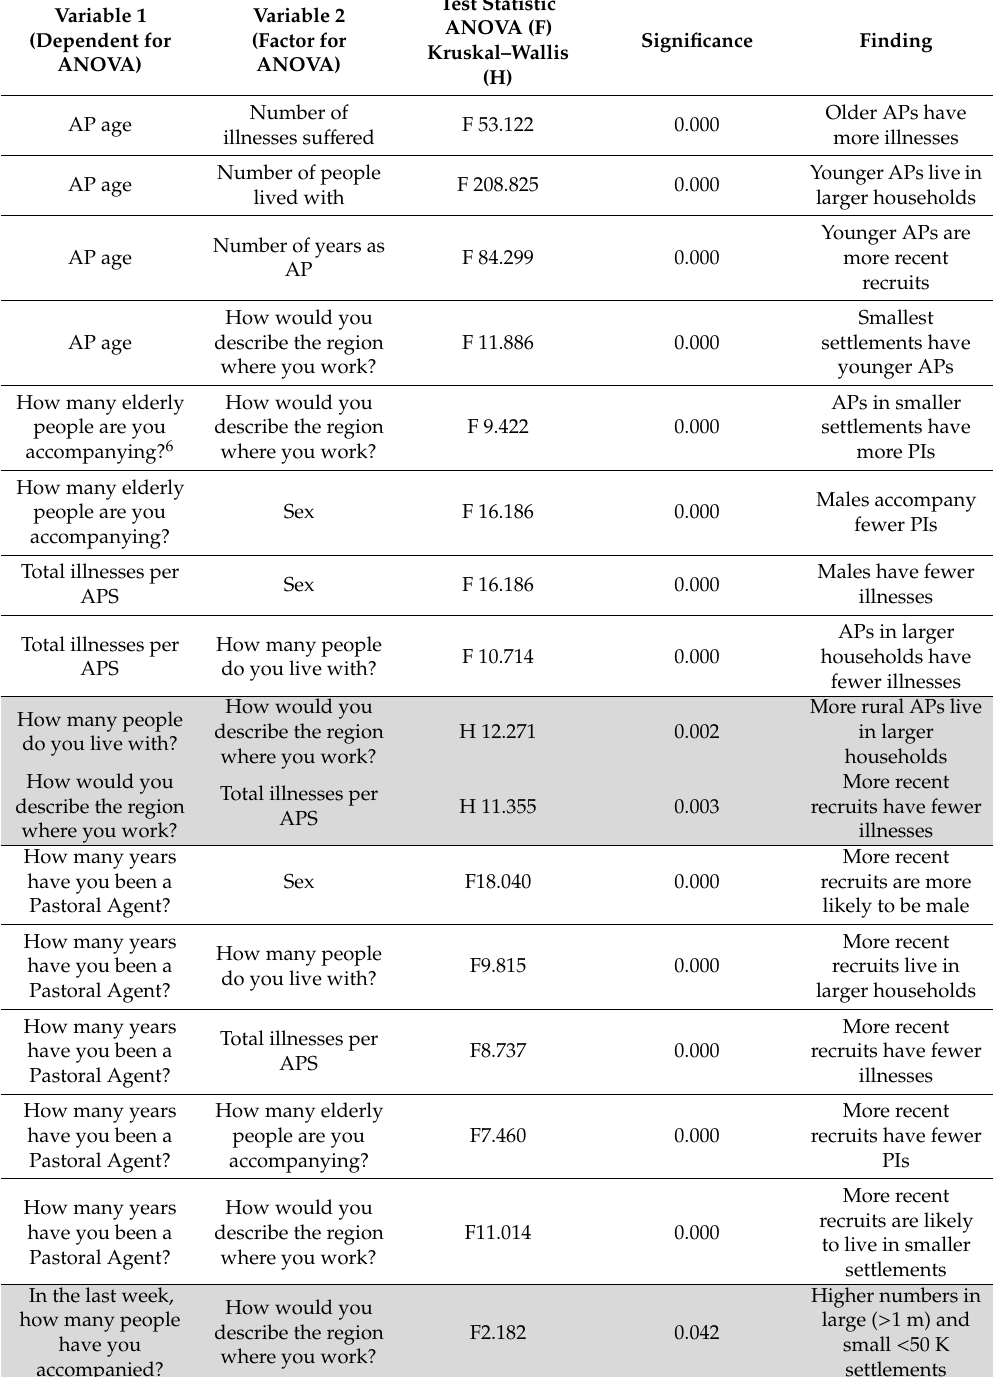
Table 2. Item correlations where statistical significance was reached (shaded rows show weak relationship). Variable 1 (Dependent